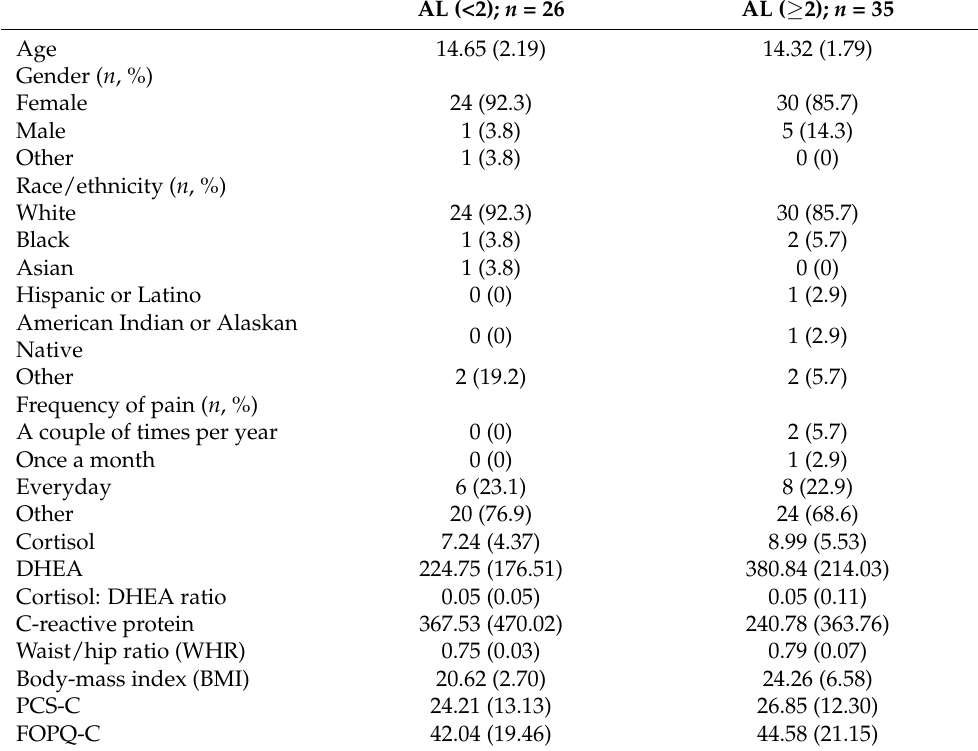
Table 2. Distribution of Key Demographic and Outcomes Variables across AL Risk